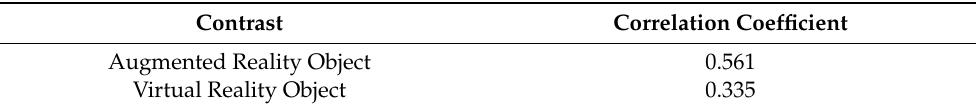
Table 11. Pearson’s correlation coefficient between the scores achieved for both instruments. Source: developed by the authors.